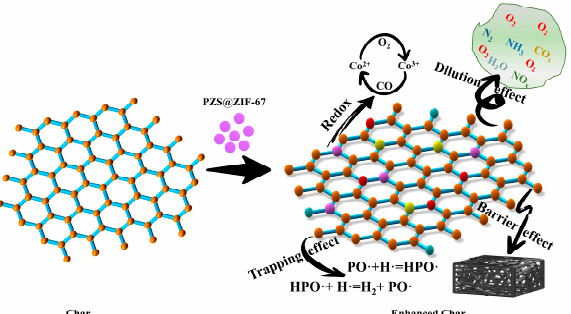
Figure 14. The possible flame-retardant mechanism of PZS@ZIF-67 composite in epoxy resin.